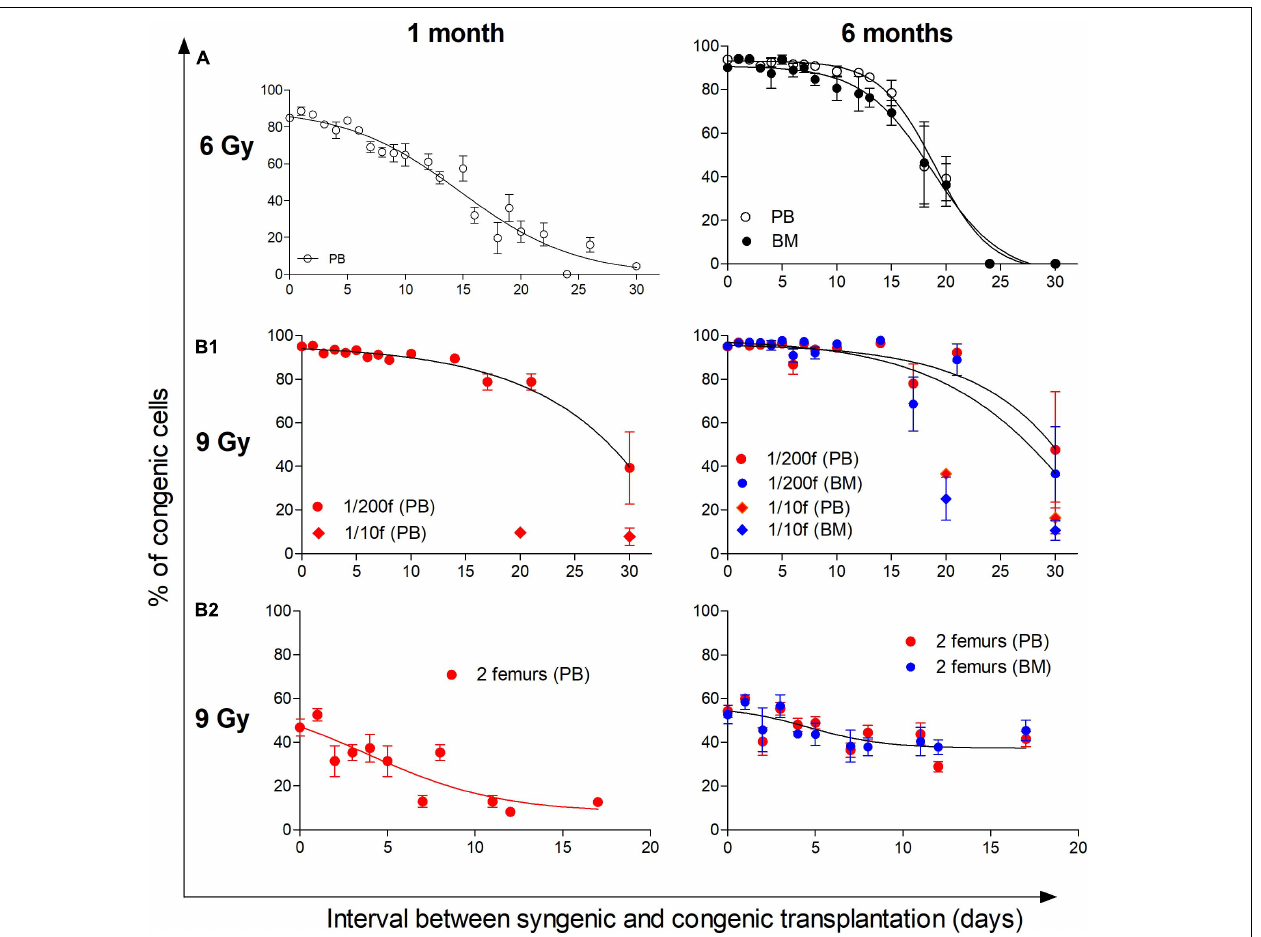
FIGURE 8 | Hematopoiesis remains permissive to transplantation during its intensive regeneration and resumption of blood cell production. The top part of the figure (A) shows the previously published results, which determined the decline in the permissiveness to engraftment of transplanted cells in 6-Gy-irradiated mice reconstituting hematopoiesis from endogenous cells (Faltusová et al., 2018). The bottom part of the figure (B1,B2) shows results from 9-Gy-irradiated mice receiving double transplants. The first transplantation used syngeneic bone marrow cells delivered shortly after irradiation. The second transplant consisted of congenic bone marrow delivered after 2 h and up to 30 days after the transplantation of syngeneic cells. (B1) Irradiated recipient mice were CD45.2, and the syngeneic cells were transplanted in an amount corresponding to 1/200 or 1/10 of the femoral marrow. Congenic bone marrow was transplanted in the amount corresponding to a half of femur. Results are pooled from four independent experiments. (B2) Irradiated recipient mice (CD45.1) were transplanted with syngeneic bone marrow from two femurs. The congenic bone marrow collected from CD45.2 mice was delivered in the same amount of two femurs after 2 h and various times till 17 days. Results are from three independent experiments. In both experiments (B1,B2) , a sample of the peripheral blood (PB) was collected 1 month after the transplantation of congenic cells, and the percentage of congenic nucleated cells primarily indicated the engraftment of progenitors. The percentage of congenic cells was again determined in the peripheral blood and bone marrow (BM) 6 months after the transplantation of congenic bone marrow cells and indicated the engraftment of hematopoietic stem cells. Data show means ± SEM ( n =